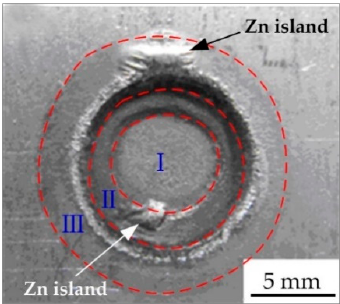
Figure 4. Three feature zones on the resistance spot weld surface.